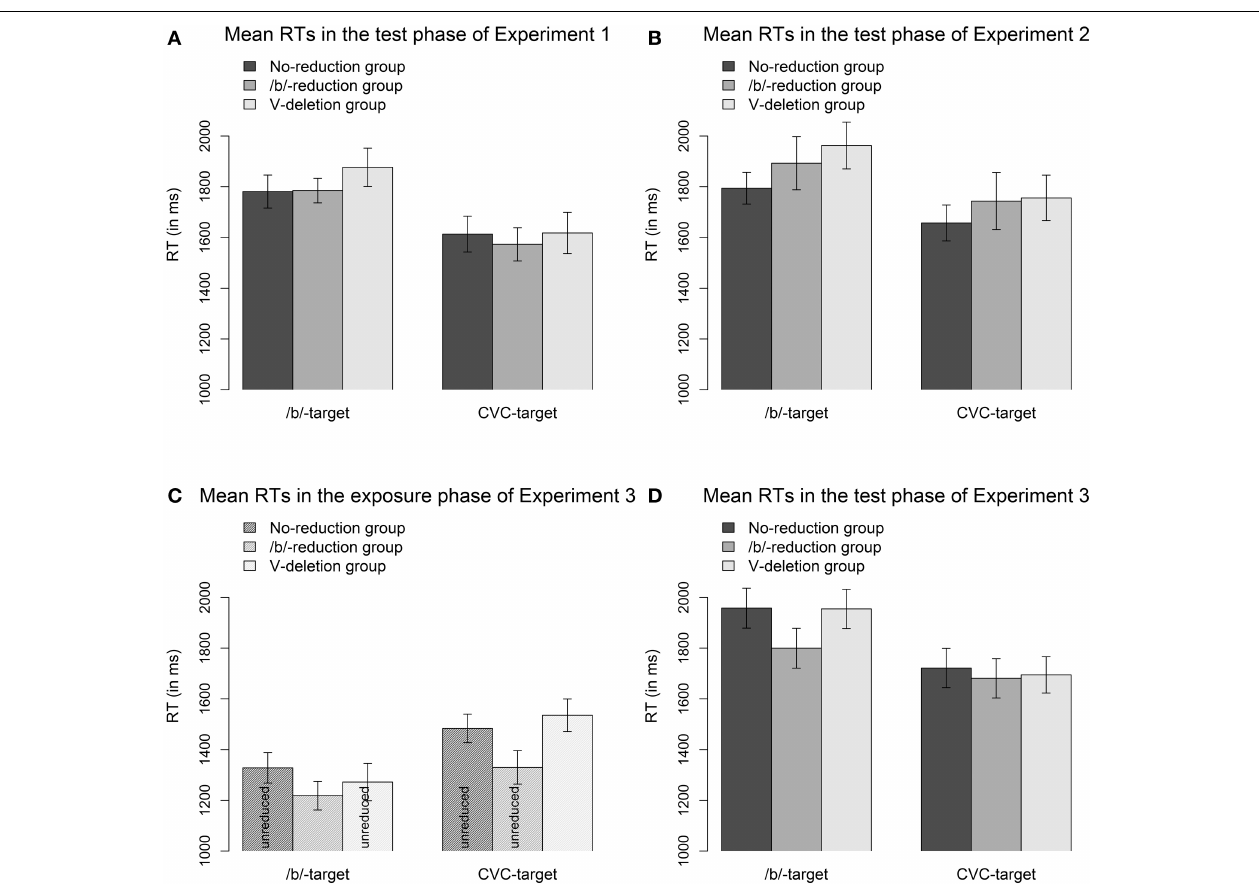
FIGURE 2 | Mean RTs and SEs in the test phases of Experiment 1 (A), Experiment 2 (B), and Experiment 3 (D) and in the exposure phase of Experiment 3 (C). In the test phases, the /b/-words and CVC-words were